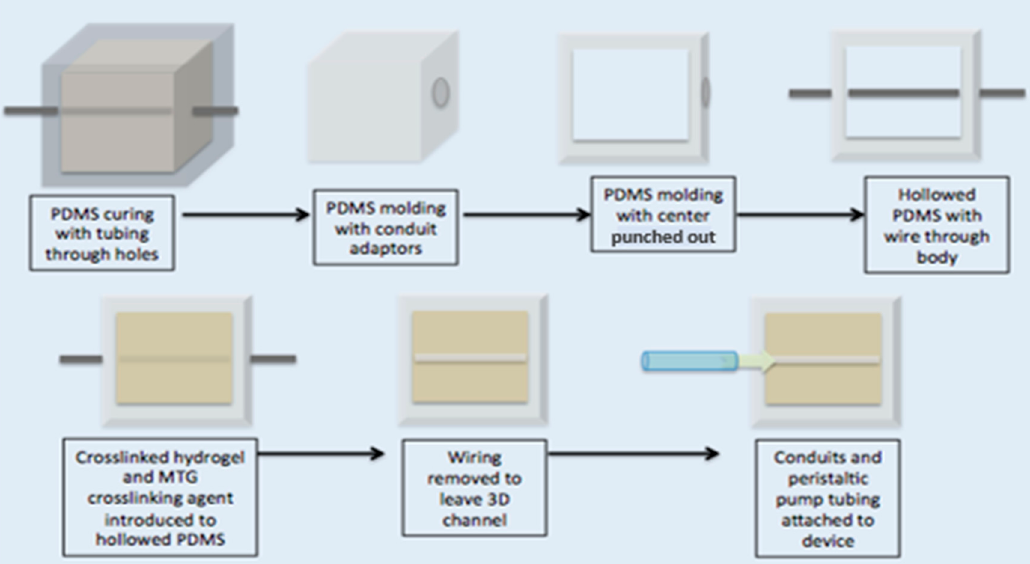
Figure 1. Schematic of artificial arteriole channel assembly. The artificial arteriole channel and PDMS mold construct was created through a series of molding and casting steps depicted above. The top row illustrates how to manufacture the PDMS mold and the bottom steps illustrate how to create the artificial arteriole construct.